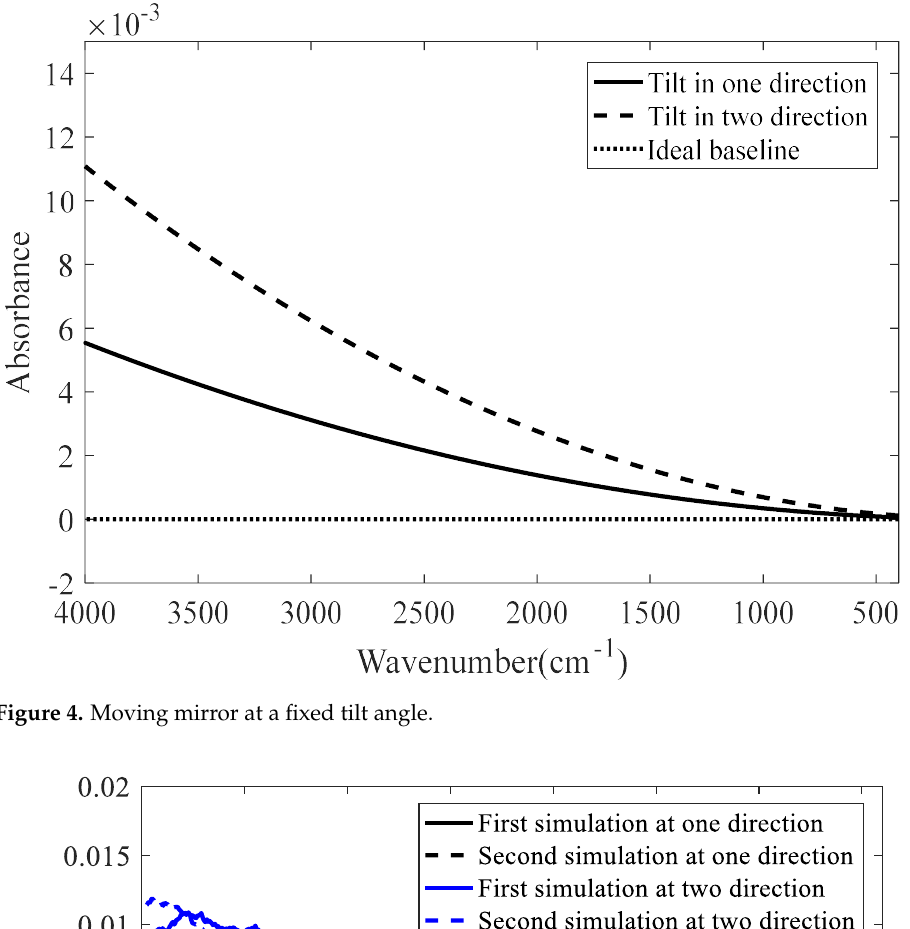
Figure 4. Moving mirror at a fixed tilt angle.